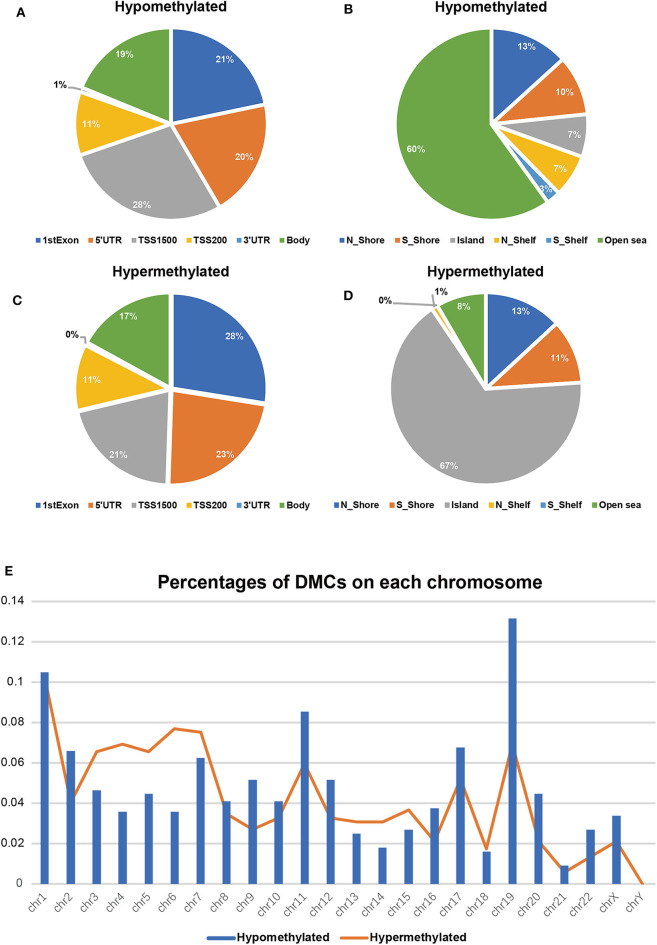
Differentially methylated CpG sites (DMCs) between HCC and adjacent normal tissues after overlapping with TCGA (n = 2,404). Hypomethylated CpG sites (n = 1832) relative to functional genomic distribution (A) and the CpG island along with its surrounding sequences (B); hypermethylated CpG sites (n = 572) relative to functional genomic distribution (C) and the CpG island along with its surrounding sequences (D). Location distribution in chromosomes between hypomethylated CpG sites (blue columns) and hypermethylated CpG sites (orange line) (E).